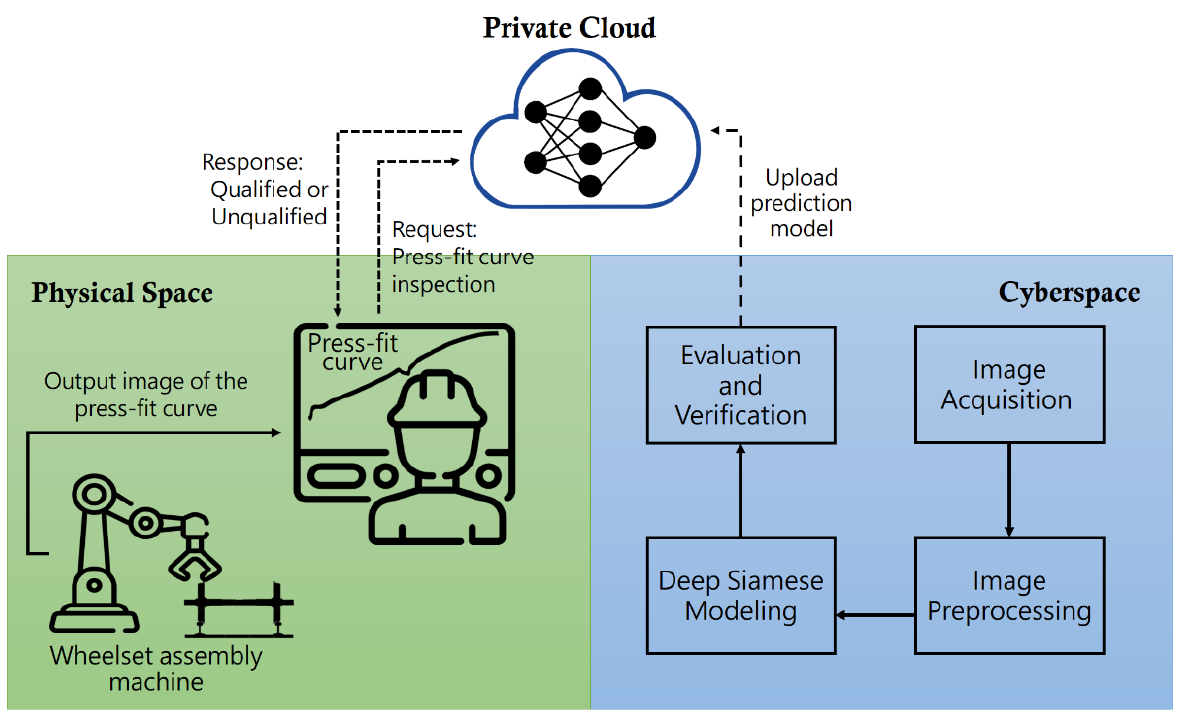
Figure 3. The system architecture of the proposed intelligent railway wheelset inspection system.